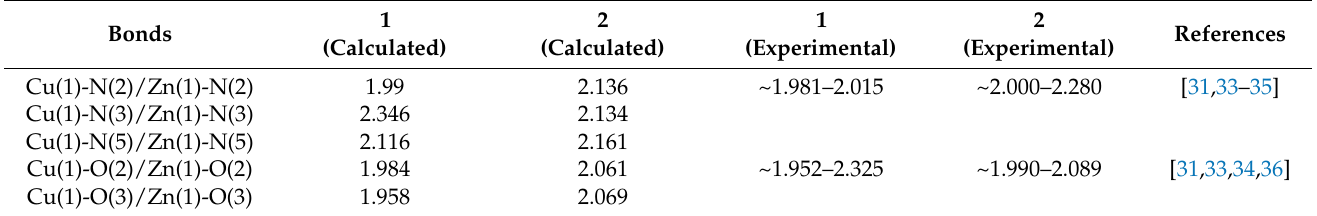
Table 2. Some selected experimental and calculated frequencies (cm − 1 ) of complexes 1 and 2